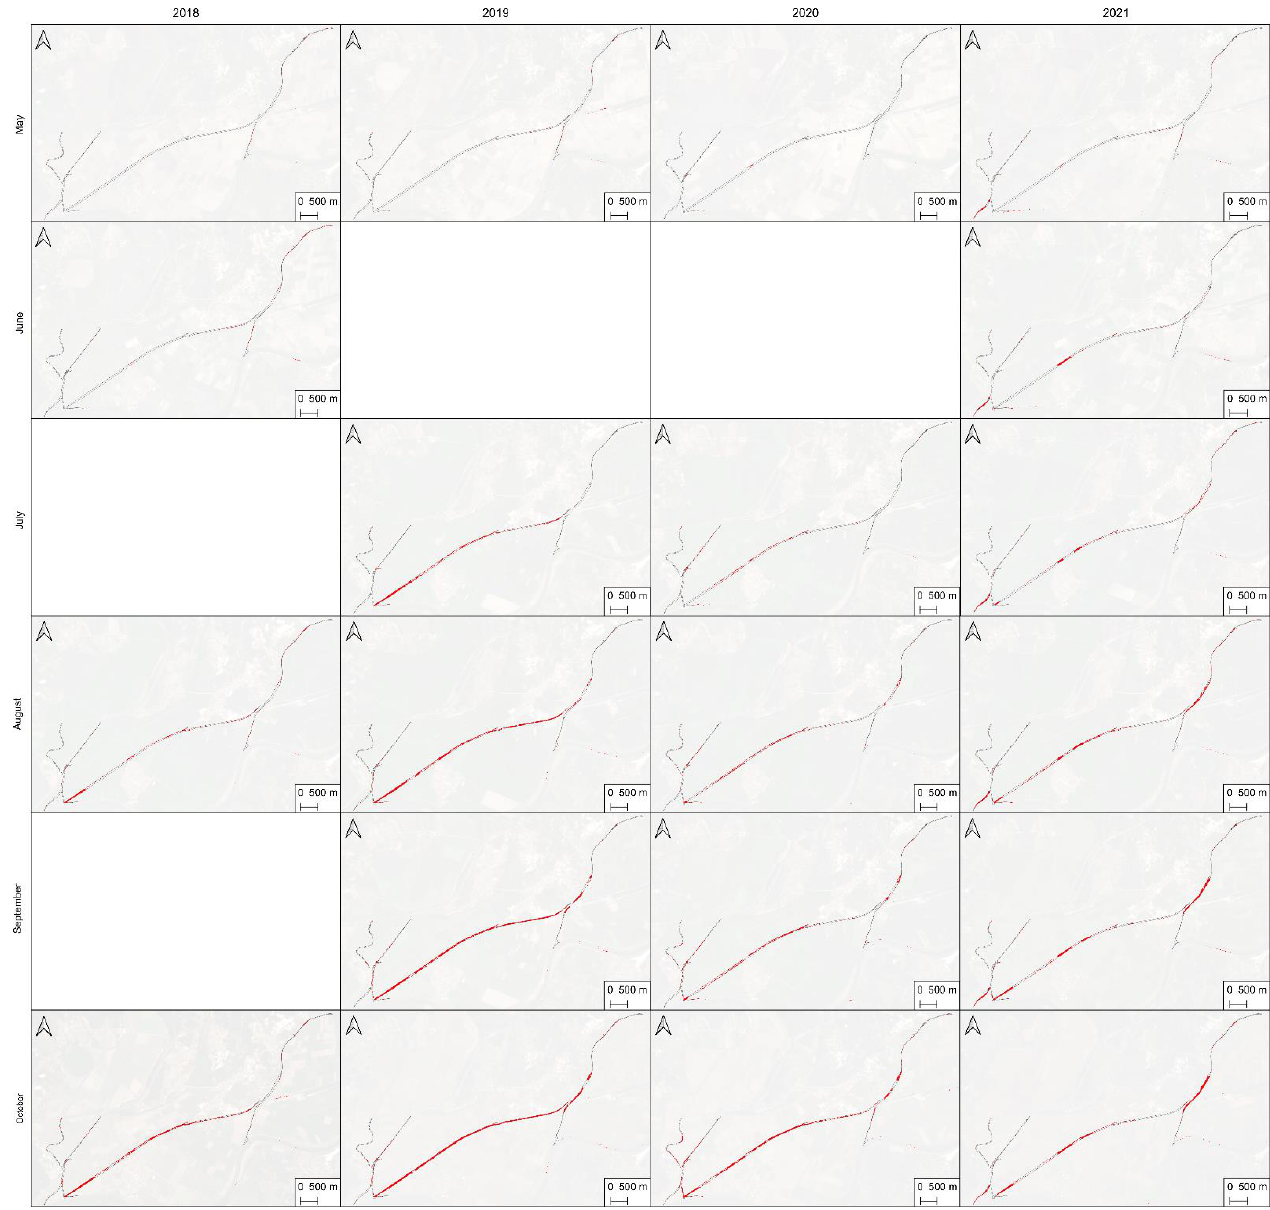
Figure A1. Water hyacinth spatial evolution in the study area between 2018 and 2021.